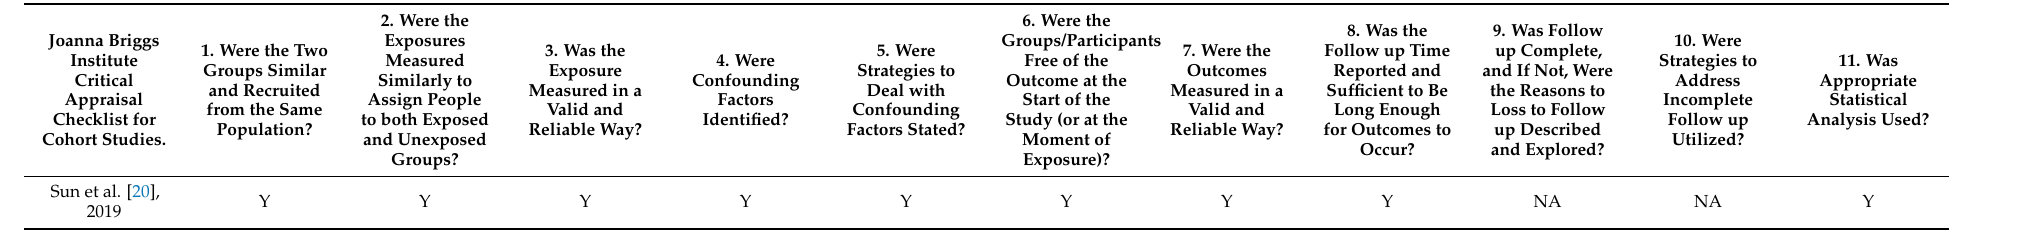
Table 4. Joanna Briggs Institute Critical Appraisal Checklist for Cohort